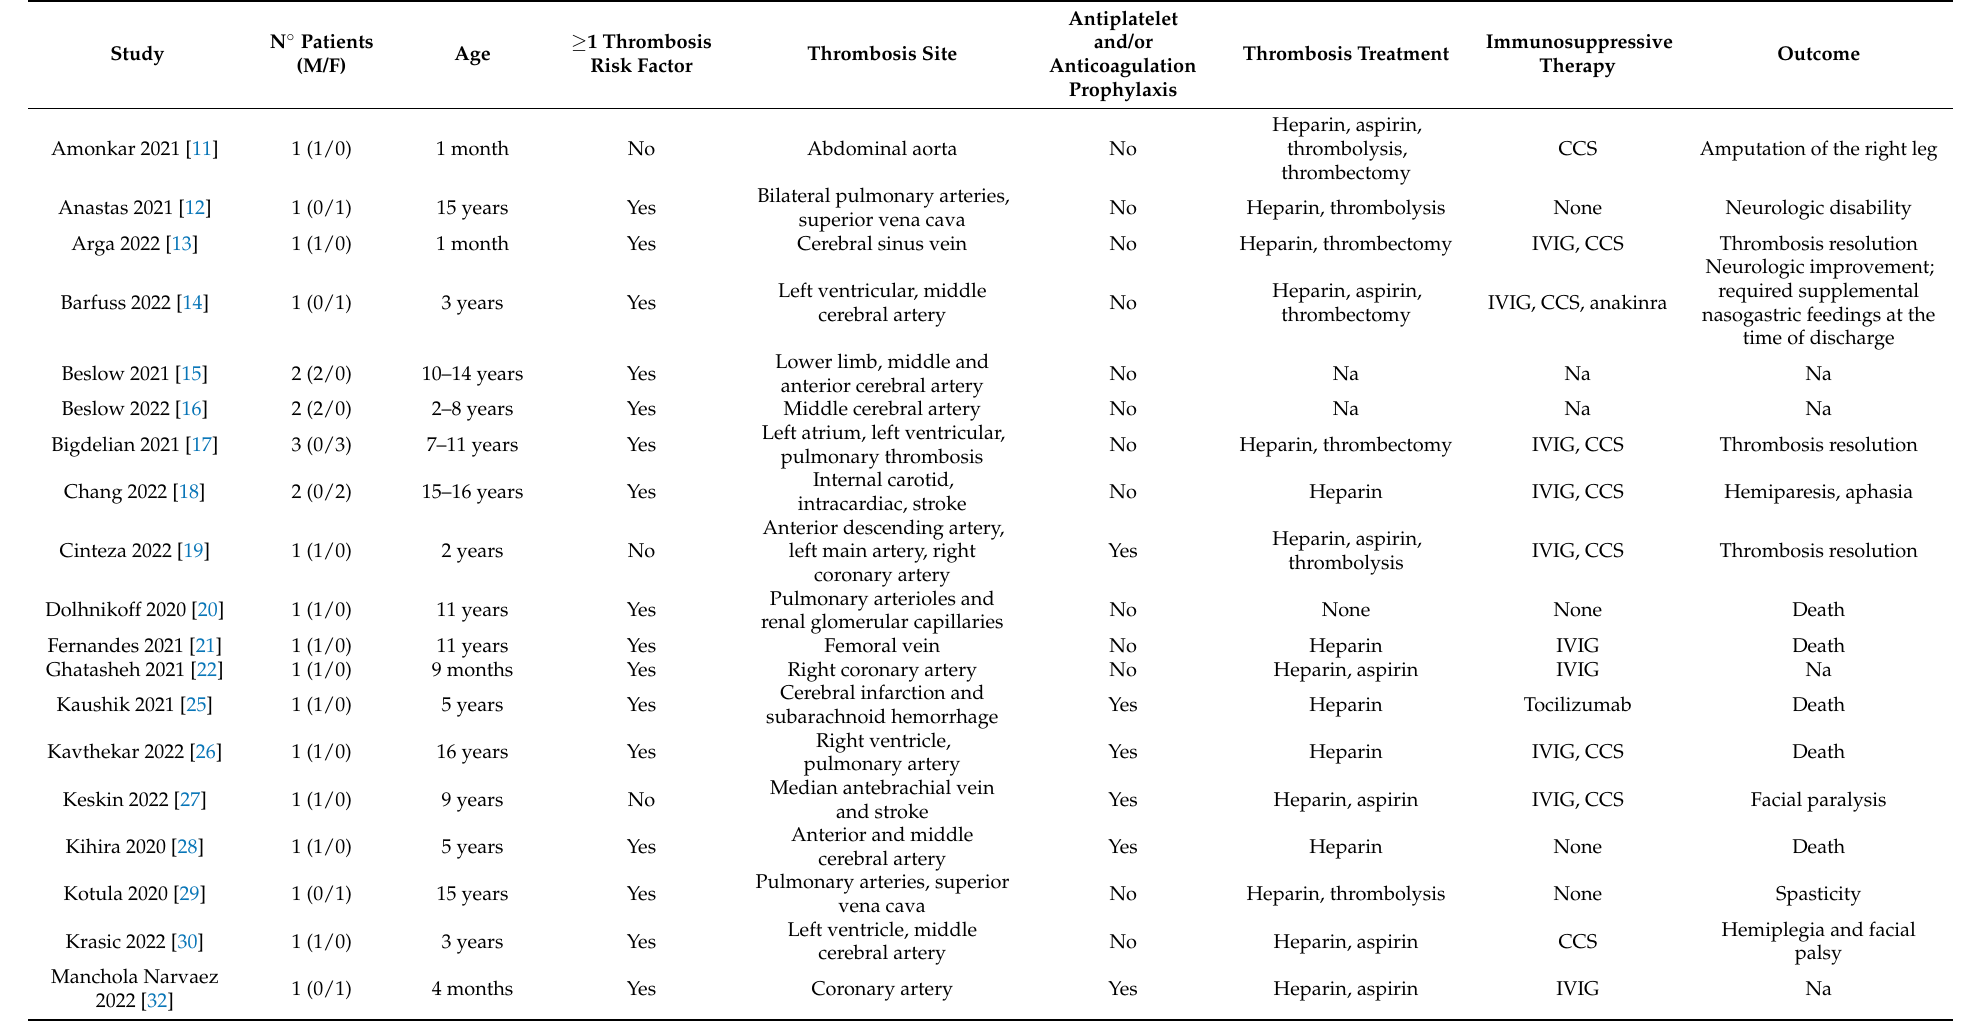
Table 1. Previously reported cases of thrombotic events in MIS-C